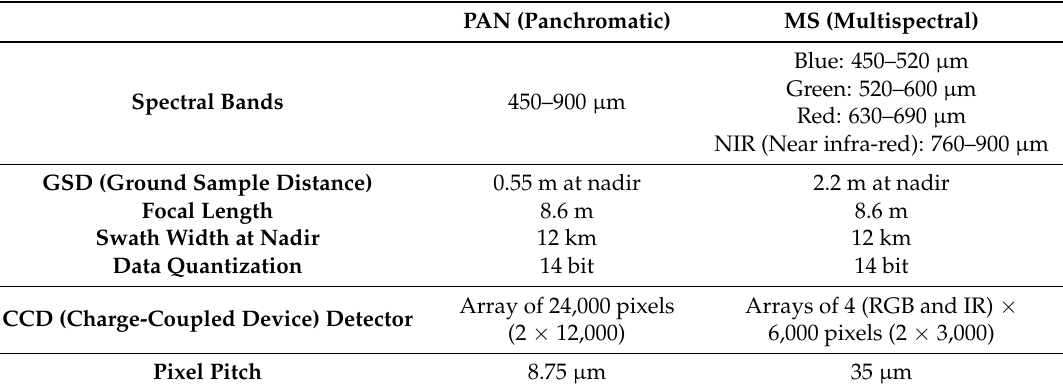
Table 1. Kompsat-3A